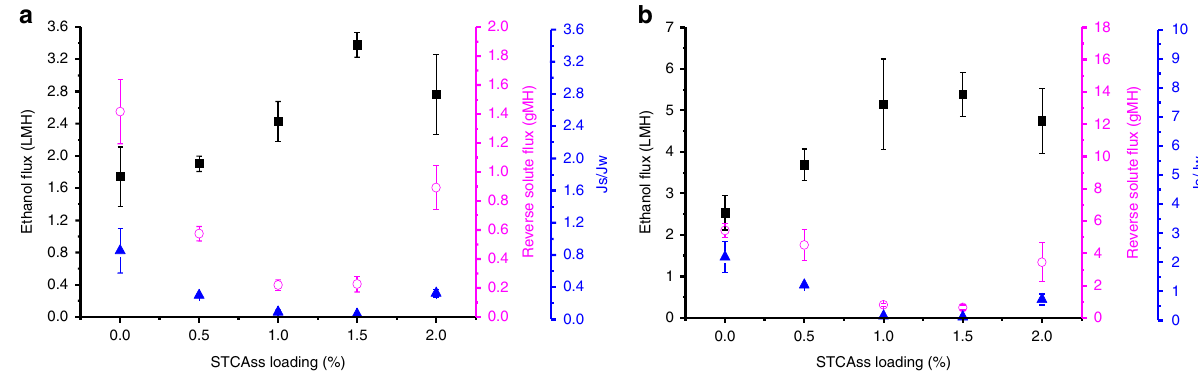
Fig. 7 Optimization of STCAss loading. Ethanol fl ux (closed square), reverse solute fl ux (open circle), and J s / J w (closed triangle) with increasing STCAss loading for a FO mode and b PRO mode. The feed solution is pure ethanol and the draw solution is 2 M LiCl in